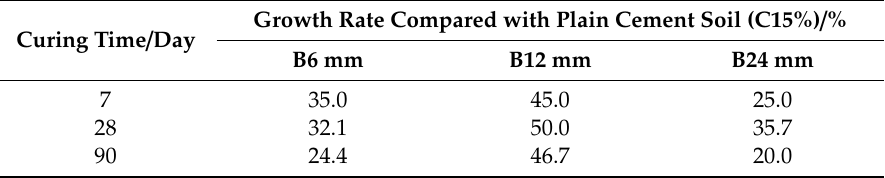
Table 6. Growth ratio of tensile strength of cement soil with different basalt fiber length. Curing Time /